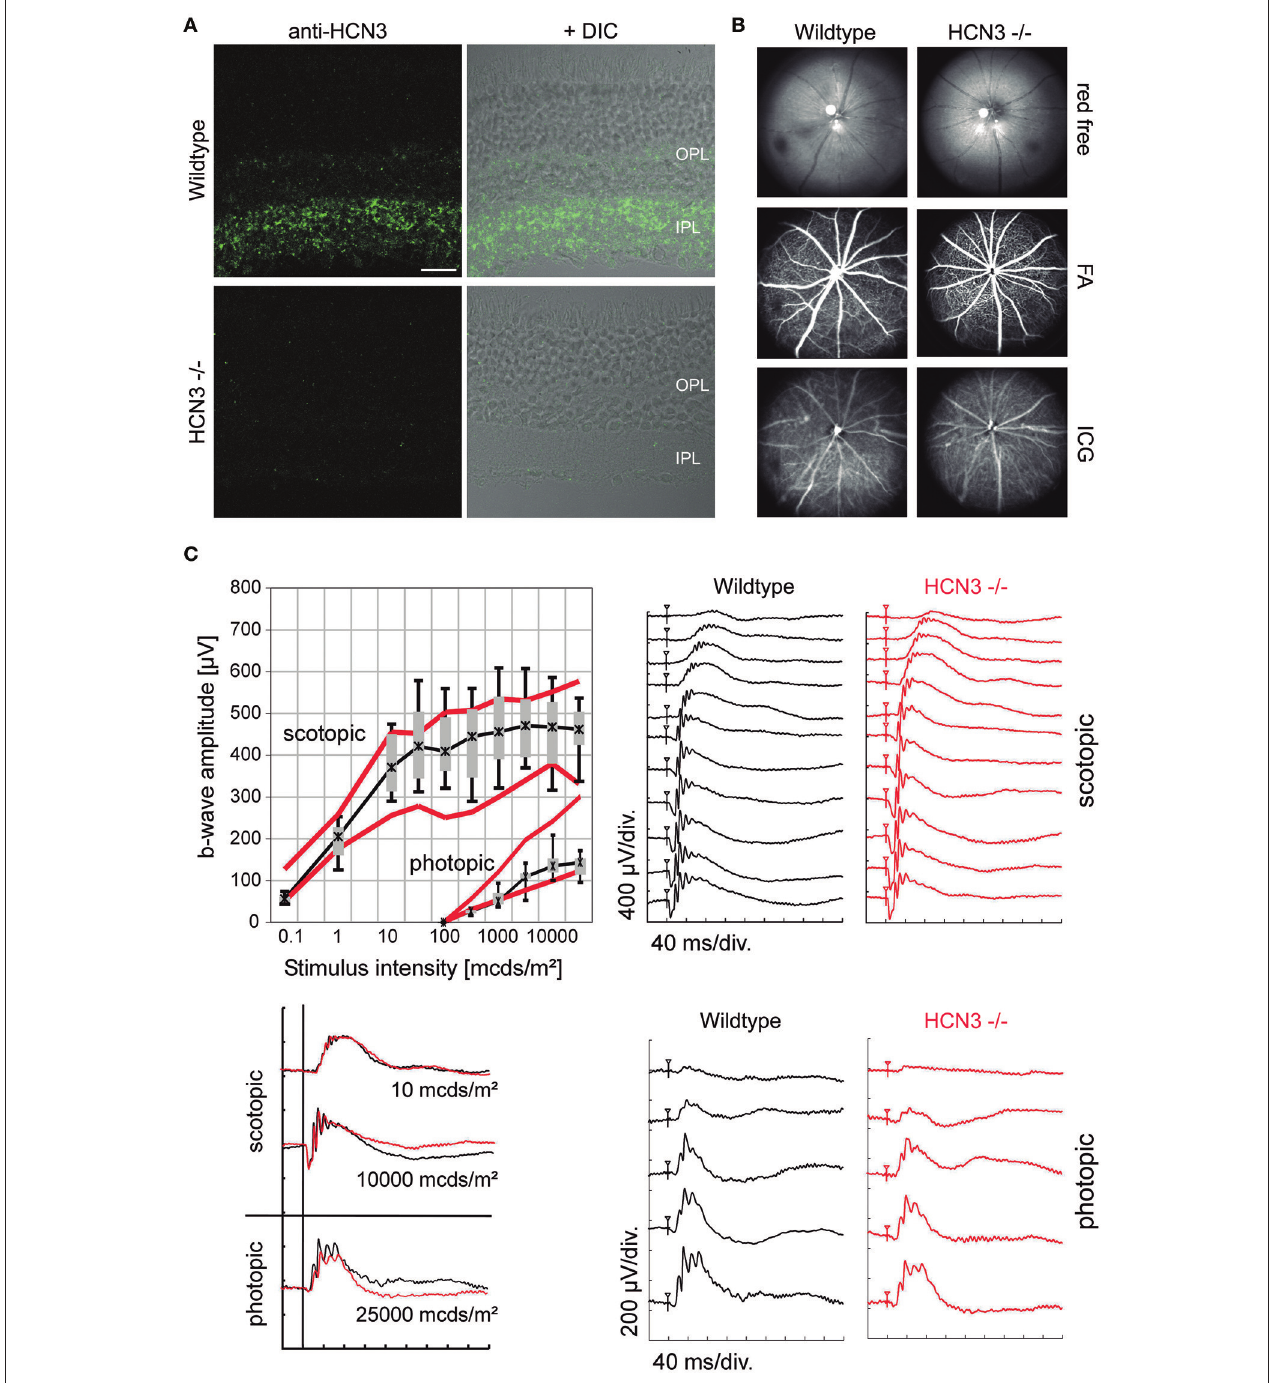
FIGURE 2 | Characterization of retinal structure and function in HCN3 − / − mice. (A) Expression of HCN3 in the retina. Wild type mice express HCN3 (green) in the inner plexiform layer (IPL) and the outer plexiform layer (OPL). The immunolabeling is absent in HCN3 − / − mice. For visualization of the retinal layers, confocal fluorescent images are overlaid with DIC images of the same area. Scale bar, 20 µ m. (B,C) Examination of retinal structure and function in vivo [wild type control mice ( n = 5) and HCN3 − / − ( n = 5), age 3 months]. (B) Retinal imaging and angiography. Mice were examined with native SLO (red-free, 514nm), fluorescein angiography (488nm, barrier filter at 500nm), and indocyanine green (ICG) angiography (795nm, barrier filter at 800nm). HCN3 − / − mice show no signs of neuroretinal or vascular alterations. (C) Retinal function assessment via ERG. Top right, Representative scotopic ERG intensity series (dark-adapted conditions). Bottom right, Representative photopic ERG intensity series (light-adapted conditions). Top left, Quantitative scotopic and photopic b-wave amplitude data from HCN3 − / − mice (box plot). Boxes: 25–75% quartile range, whiskers: 5 and 95% quantiles, asterisks: median. As a control, red bolded lines indicate the 25 and 75% quartile of the wild type group. bottom left, Overlay of representative ERG recordings under scotopic (0.01 and 10 cd*s/m ² ) and photopic (25 cd*s/m ² ) conditions. Wild type black traces, HCN3 − / − red traces.